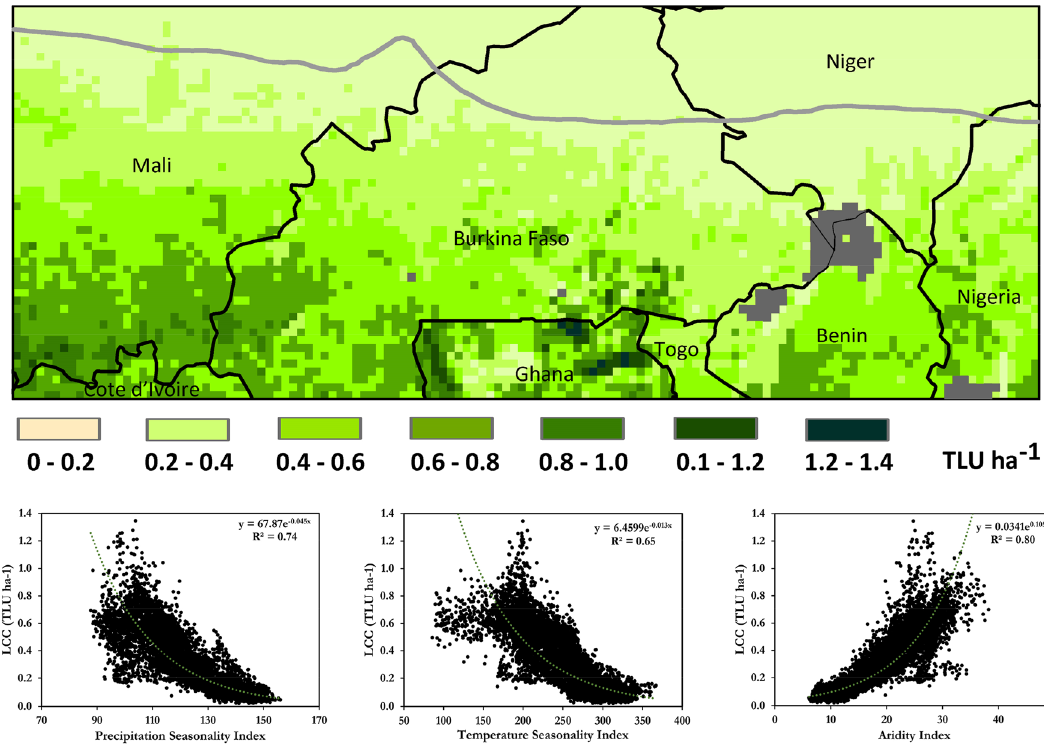
Figure 4. Average LCC over the historical period of 1981–2020. The lower panels show results of nonlinear regression analysis between regional bio-climatic variables and LCC. Figures were generated using ArcGIS 10.8.1 (https:// www. esri. com/ en- us/ arcgis/ produ cts/ arcgis- pro/ overv iew) and Microsoft Excel 2016 (https:// www. micro soft. com/ de- de/ micro soft- 365/